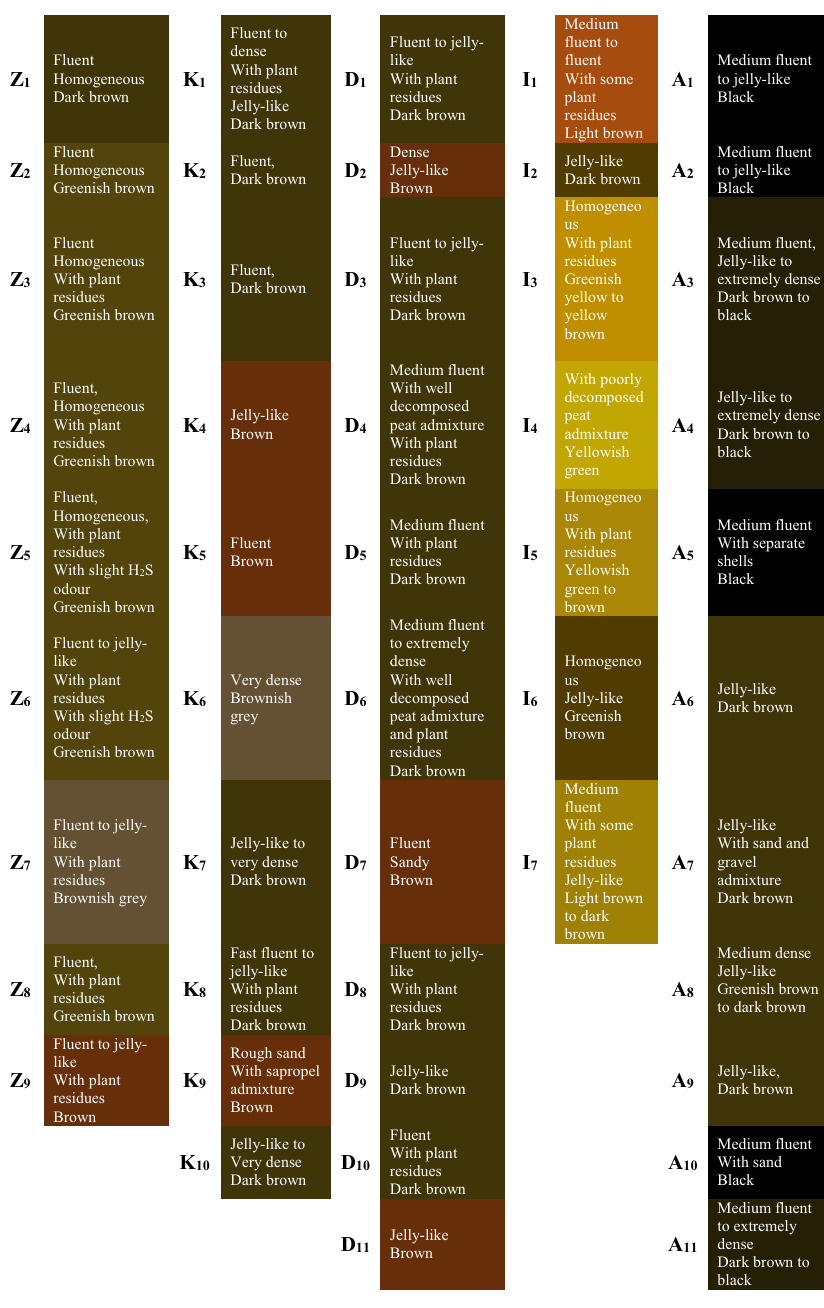
Table 2. Lithological description of the sapropel exploration points.